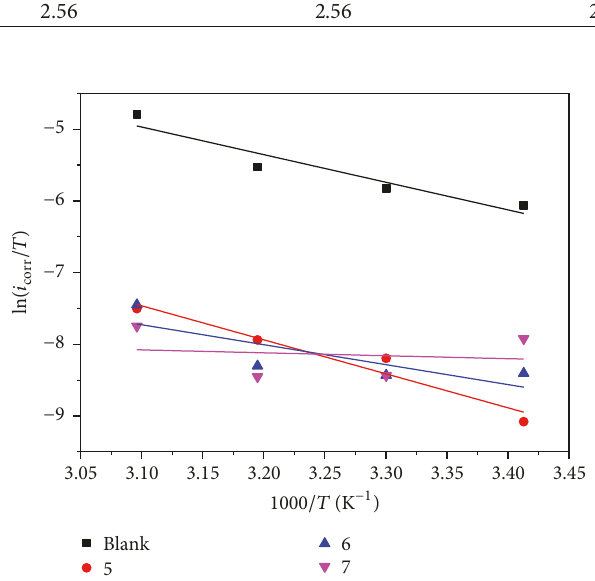
Figure 7: Transition-state plots of ln (𝑖 corr /𝑇) versus 1/𝑇 (K −1 ) in 1MHCl in the absence and presence of 5mM of